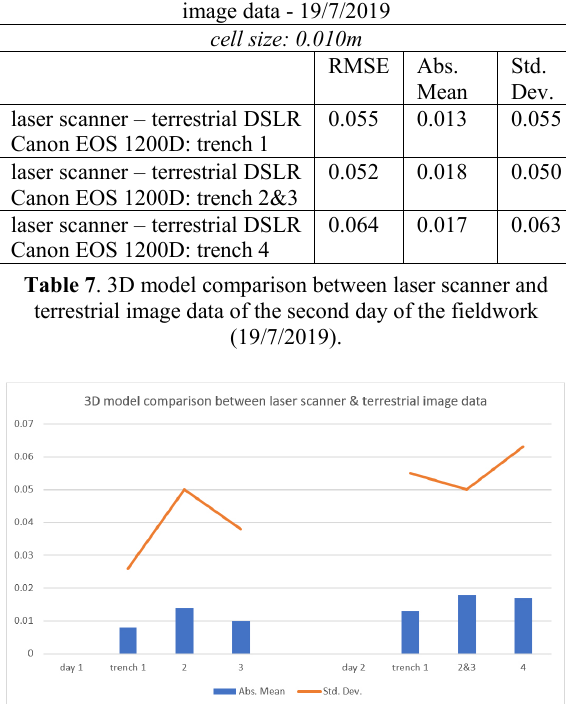
Figure 13 . Monochromatic rendering of the “difference image” resulting from the 3D model comparison (19/7/2019) between laser scanner and terrestrial DSLR Canon EOS 1200D of the: (I) first, (II) second and third, (III) forth archaeological trench. 3D model comparison between laser scanner & terrestrial